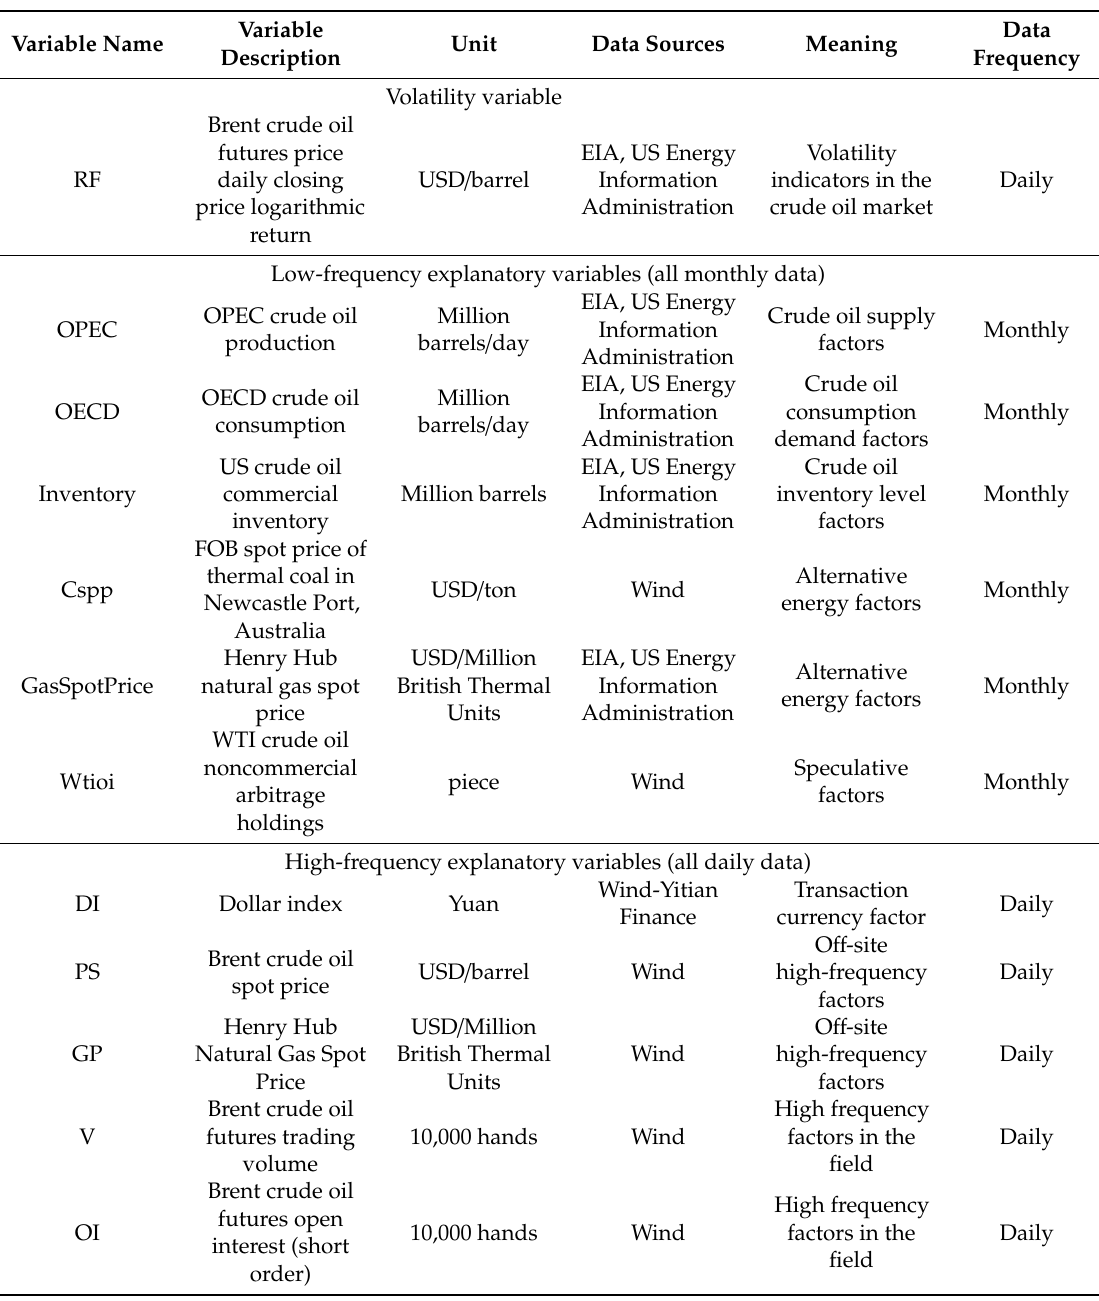
Table 1. Variable descriptions and data